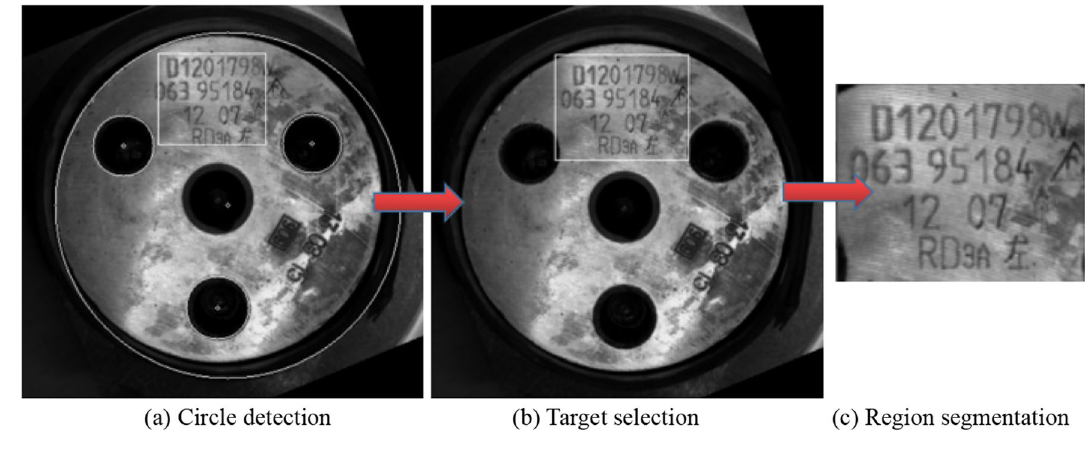
Fig. 17 Target region segmentation based on structural features